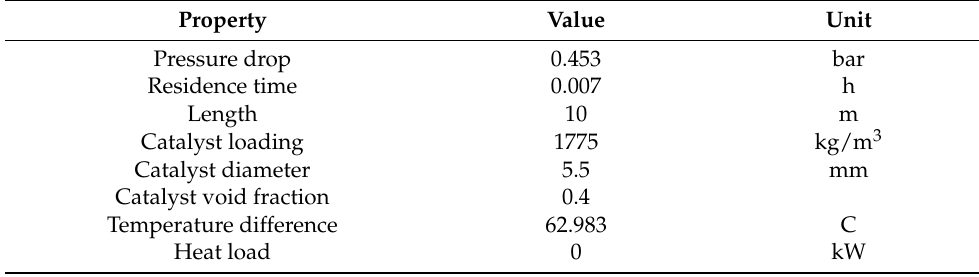
Table 4. Packed bed reactor